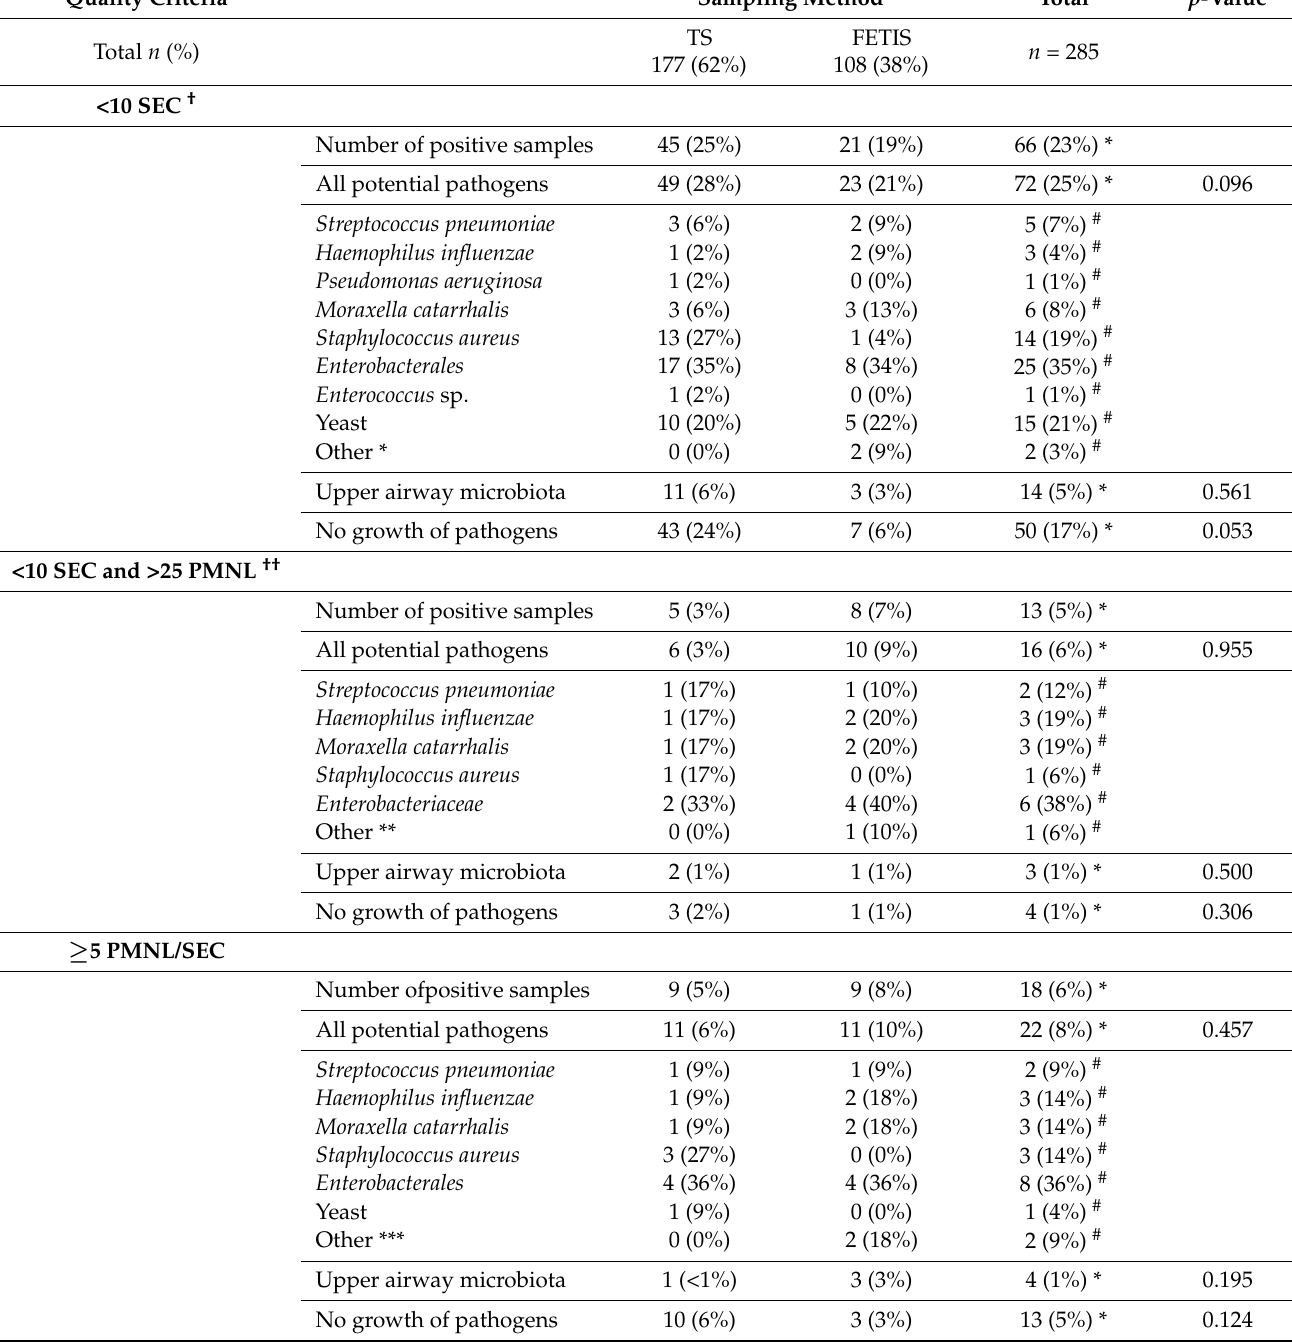
Table 2. Culture results for TS and FETIS stratified on different quality